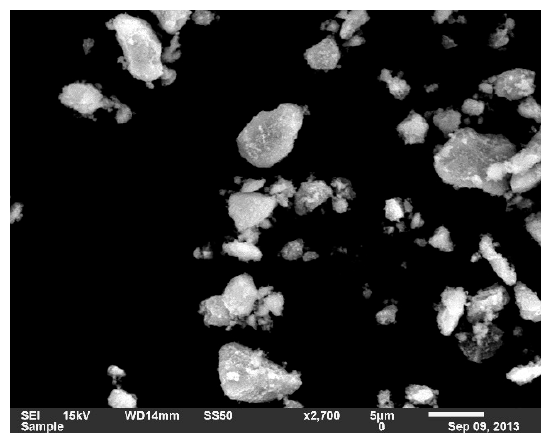
Figure 2. scanning electron microscope (SEM) image of the prepared NPs. Figure 2. Scanning electron microscope (SEM) image of the prepared